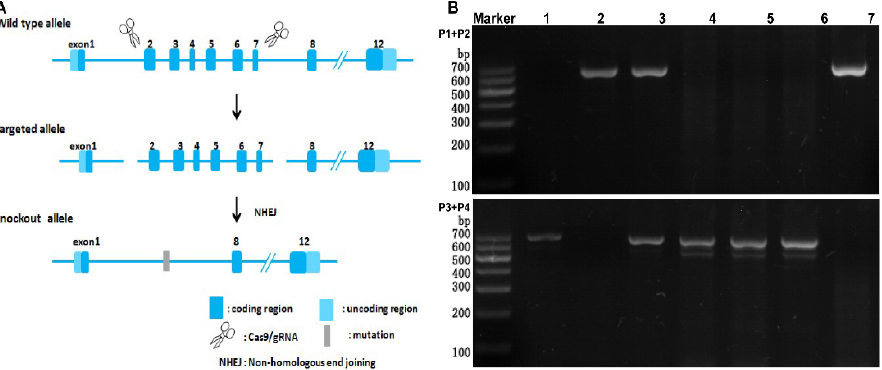
Figure 1. Strategy for the targeted disruption of the SR − B1 locus in mice ( A ); detection of the expression of SR − B1 mRNA by RT − PCR , 1, 4, 5, and 6—C57 mice, 3—SR − B1 +/ − mouse, 2 and 7—SR − B1 − / − mice ( B ).